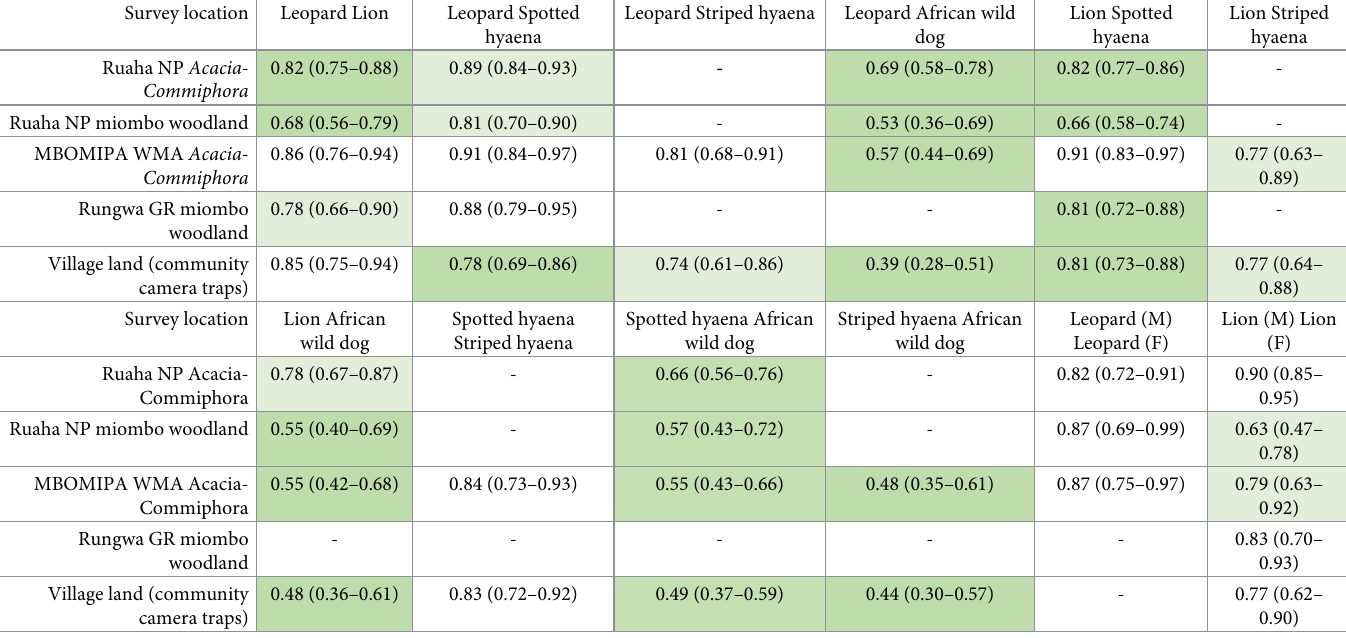
Table 3. Coefficients of overlap ( Δ ) for all large carnivore species pairs at each survey site.